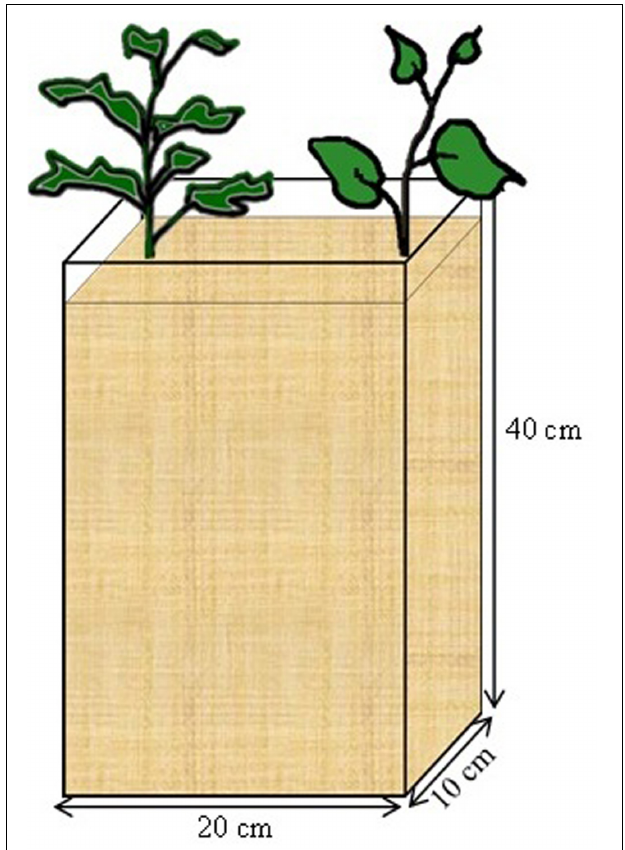
FIGURE 1 | Rootbox constructed with 1 cm thick PVC plates (bottom and sides) and removable plexiglass plates (front and back). The